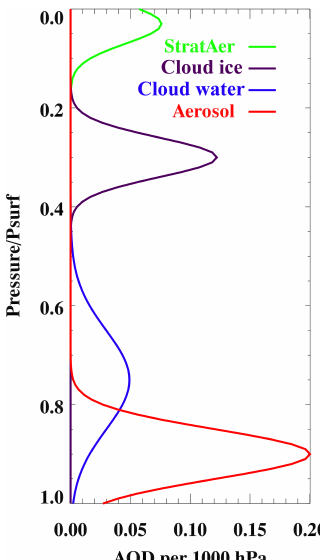
Figure 1. Prior Gaussian profiles of the lower tropospheric aerosol types (red), water cloud (blue), ice cloud (purple), and stratospheric aerosol (green). The local AOD per unit of pressure at 755nm is plotted as a function of the relative pressure. The lower tropospheric aerosol prior AOD is not fixed as for the other types, but rather it is taken from a climatology described in the text. Taken from O’Dell et al.